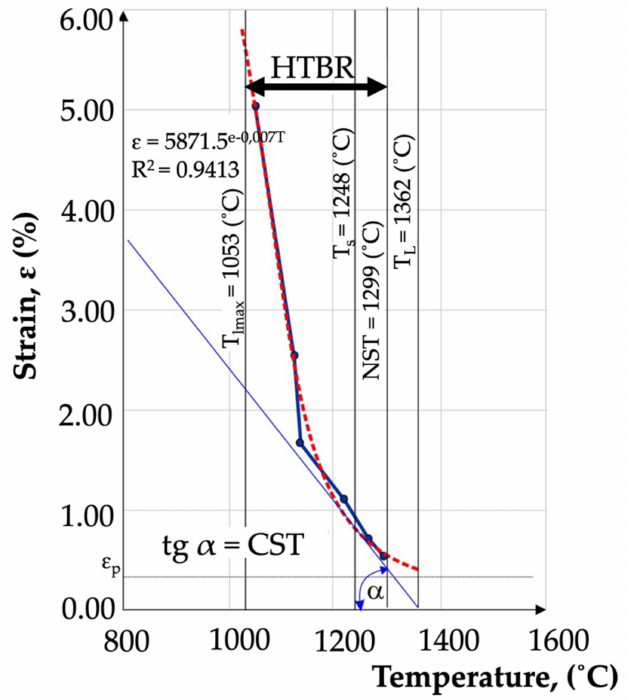
Figure 16. Strain as a function of temperature for Inconel 713C precision castings, determined based on transvarestraint